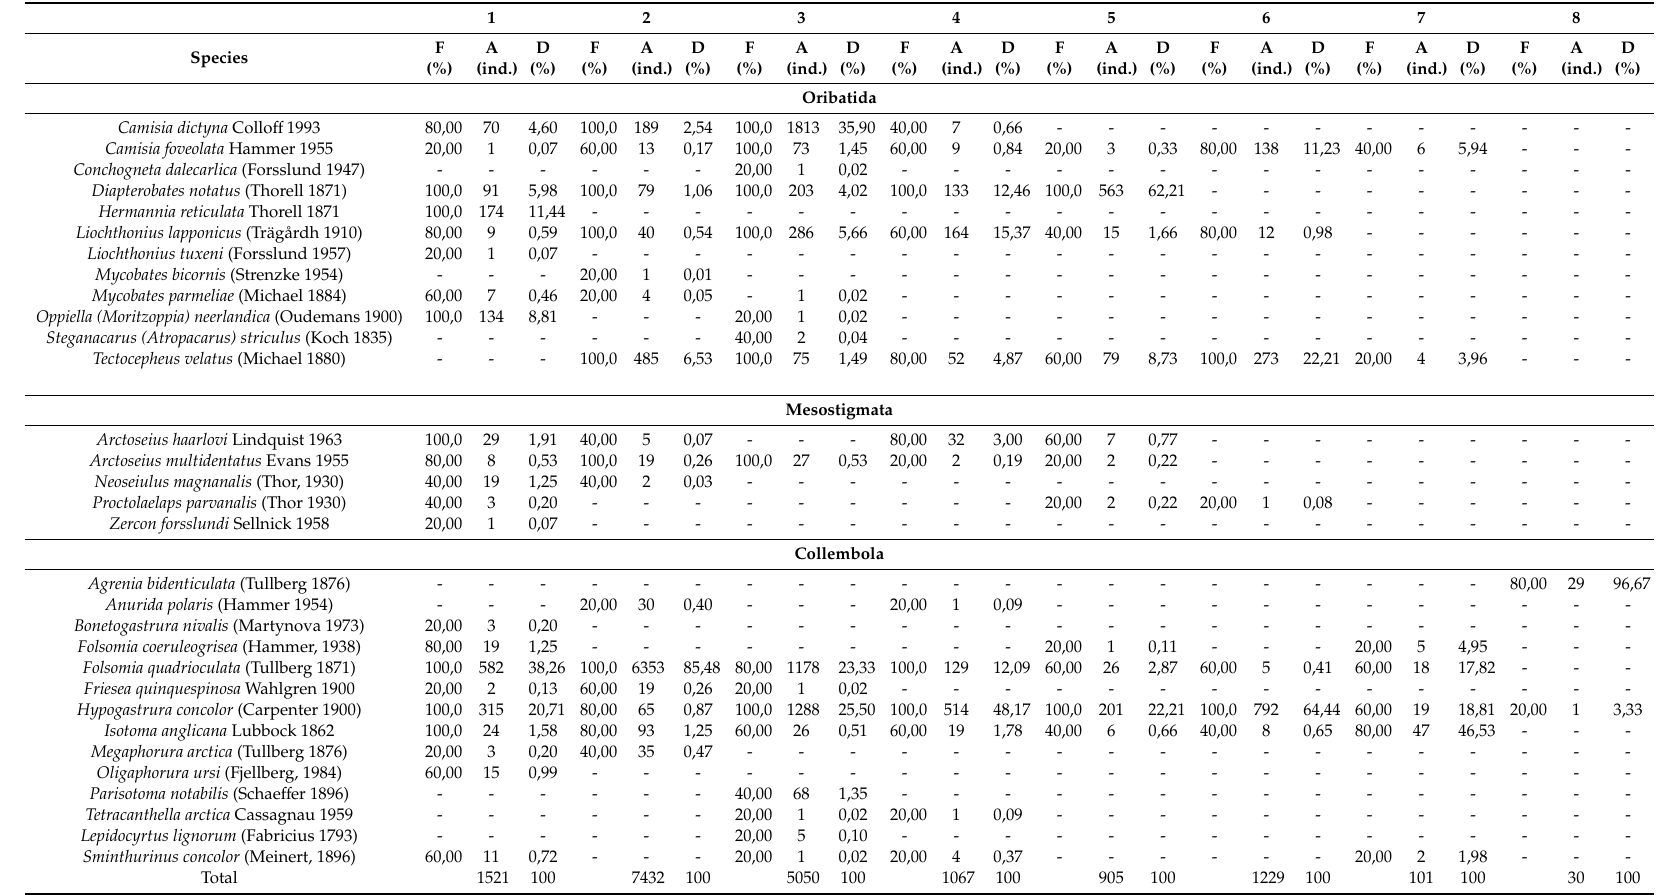
Table A1. 1 to 8 in the table legend refer to the sampling sites from the most distant to the closest to the glacier